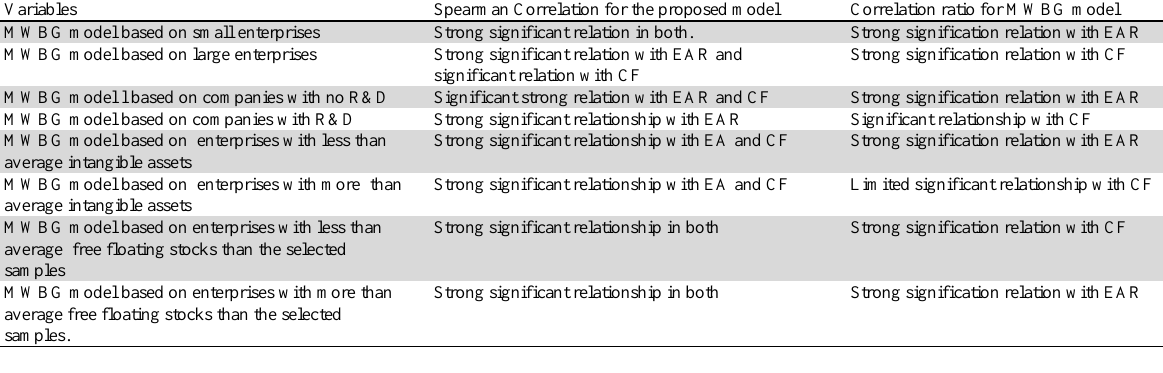
Comparison between correlations among different